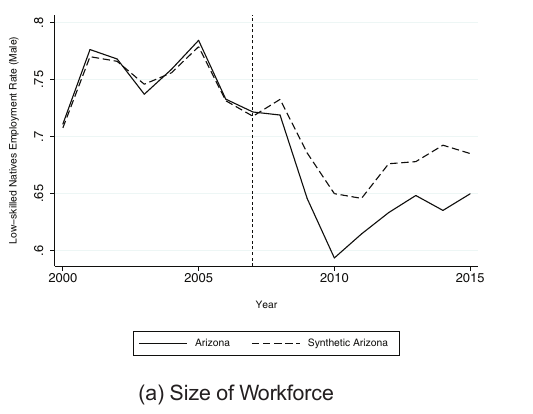
Figure A31 Low-skilled natives employment rate (male)